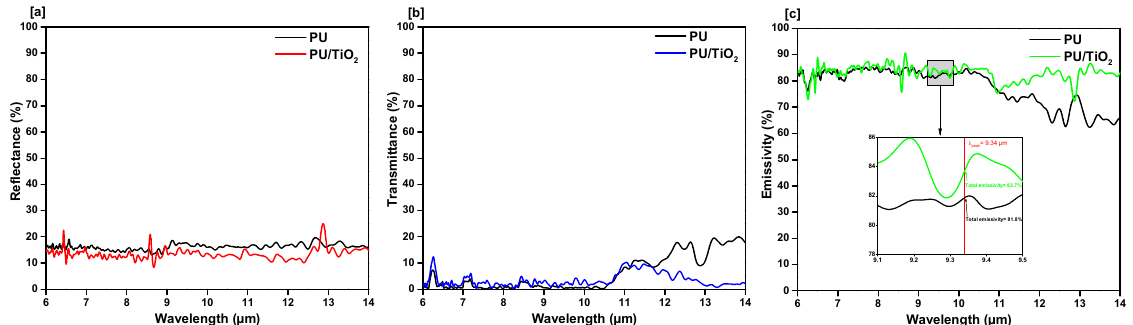
Figure 5. FIR property characterization of titanium dioxide incorporated PU films. FTIR measured ( a ) reflectance, ( b ) transmittance, ( c ) emissivity.